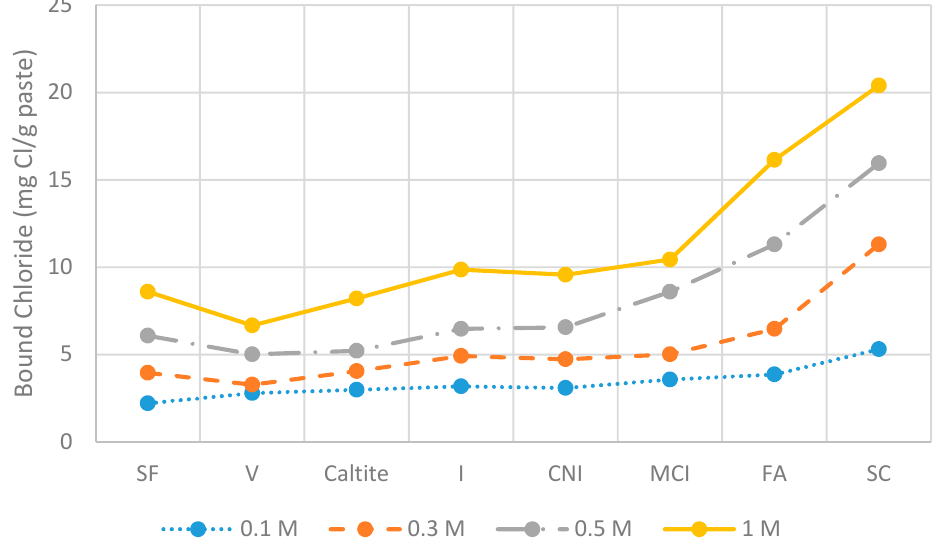
Figure 3. Overall performance of the mixes at each free chloride concentration.